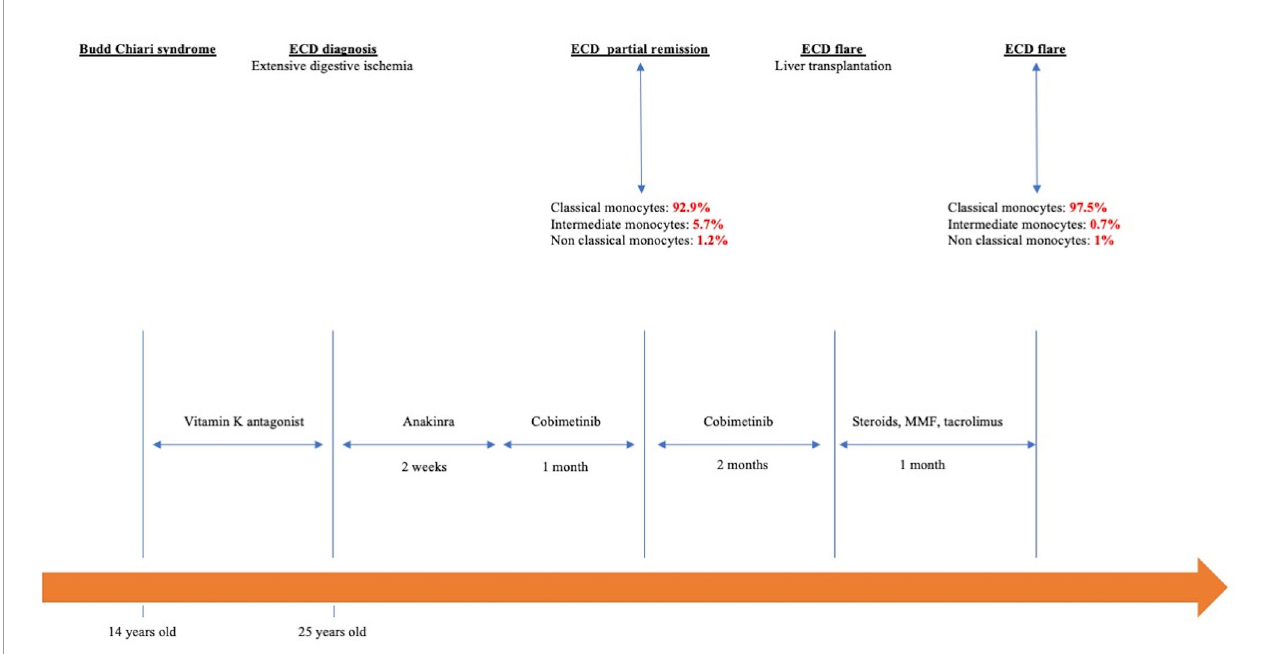
FIGURE 3 | Chronological history of the patient from Budd – Chiari syndrome to